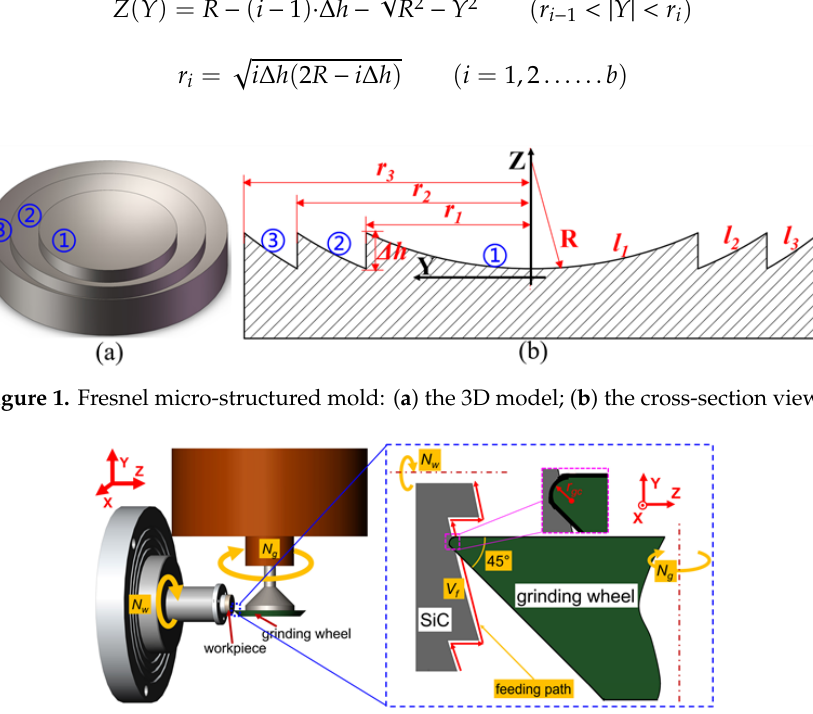
Figure 2. The grinding device scheme for the Fresnel micro-structured